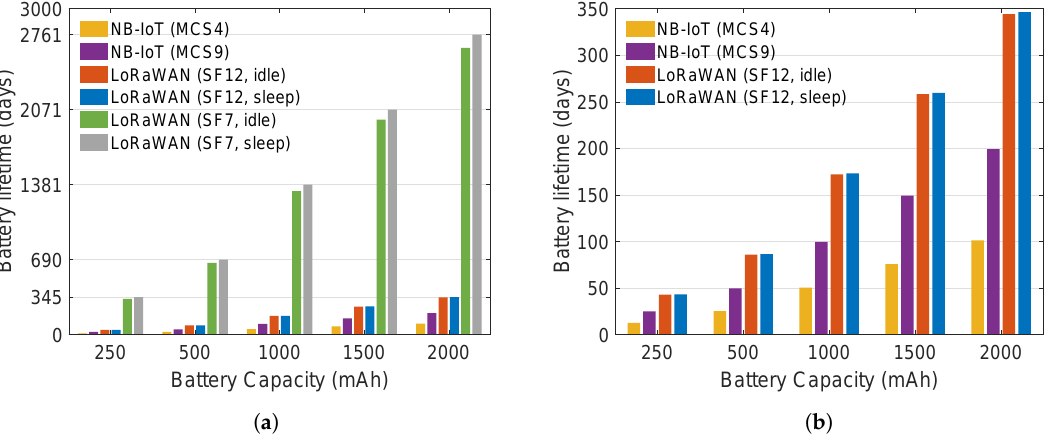
Figure 6. Battery lifetime of a device (both radio and microcontroller) transmitting once every 10 min for long-range technologies (<10 km). ( b ) is a subset of ( a ) where LoRaWAN SF7 is omitted for